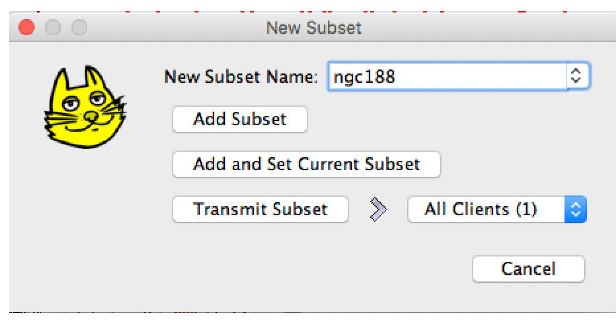
Fig. 67.— The “New Subset” window over again with selecting your subset.)